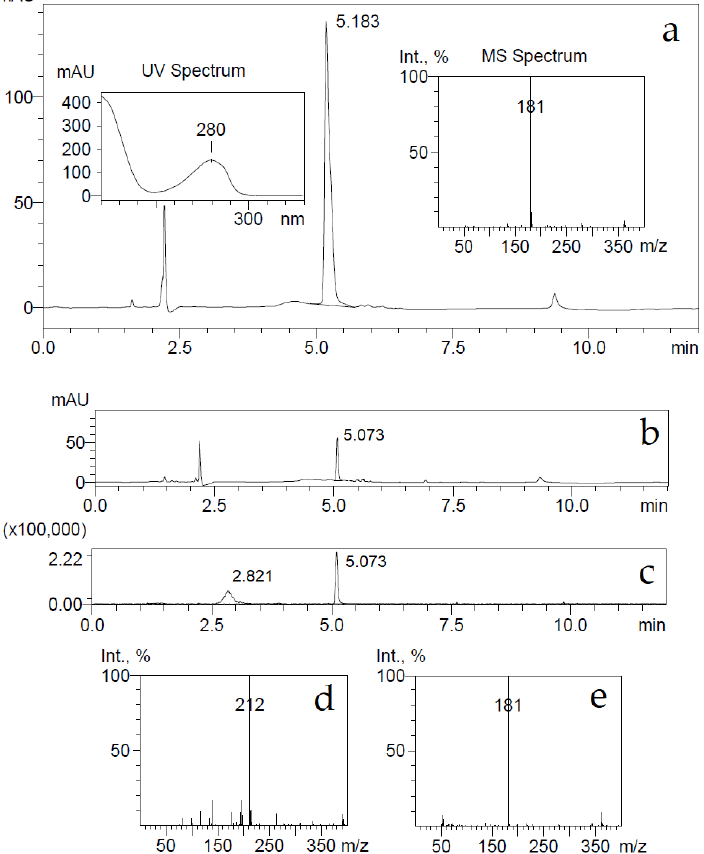
Figure 4. ( a ) Bioconversion of 7-hydroxycoumarin by E. coli BL21 bacteria harboring the pHP4-10